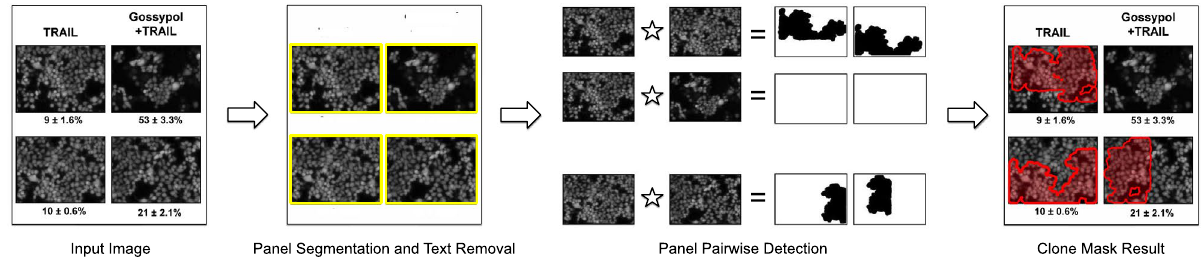
Figure 9. A block diagram depicting the operation of the copy-move detection solution implemented in SILA. First, a given image is segmented into sub-panels and overlaid texts are removed. The resulting sub-panels are then combined two-by-two, leading to panel-pairwise single images submitted to the copy-move detector. After all the possible sub-panel pairs are processed, the multiple resulting cloned-region masks are combined, leading to the final clone mask result. All original panels within this figure belong to a paper published as Creative Commons content, under DOI https:// doi. org/ 10. 1074/ jbc. M110. forensic container , a standalone executable piece of software that contains everything needed to run it, including libraries, configurations, and even specific operating-system environments. By using tools such as Docker 44 , novel and better forensic tools can be easily added to the system, as long as they are bundled as a container. Concerning the task of content extraction, we used MuPDF 45 —an open-source software library developed to parse PDF streams—to read the cross-reference ( a.k.a. Xref) tables of a given PDF document, and extract the indexed and stream-embedded images. To gather text, we relied on PDFMiner 46 , another open-source Python